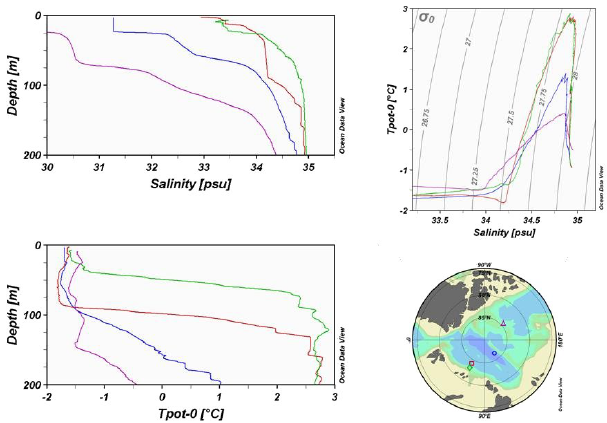
Fig. 5 . Profiles of salinity and potential temperature and θS curves from the upper layers in different parts of the Arctic Ocean showing the upper temperature minima created by winter convection. Only at the Eurasian continental slope (green station) is the minimum absent, indicating that warmer water is entrained from below into the mixed layer in